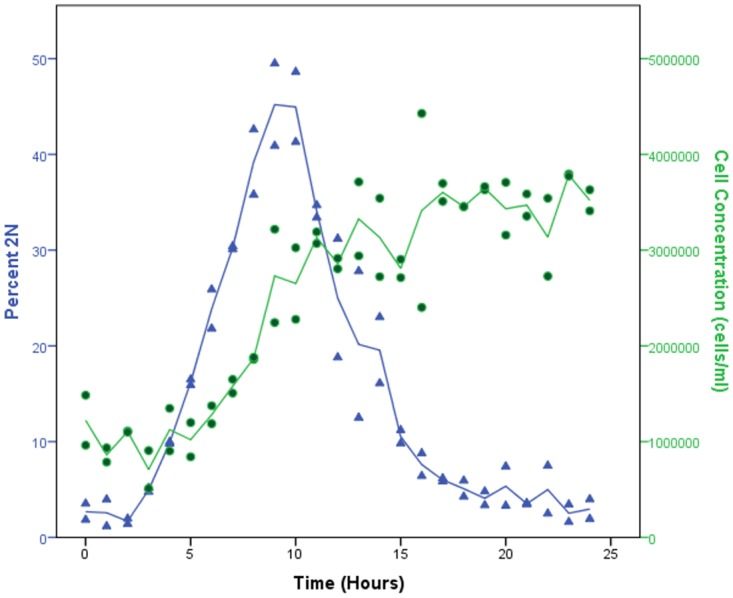
Cell division in early logarithmic cultures.Comparison of diploidy percentage with haemocytometer counts of gametogenesis ploidy time course. The largest increase in the cell population occurs prior to the peak in diploid cells, slowing as cell division ceases. Fitted with straight interpolation line in SPSS.